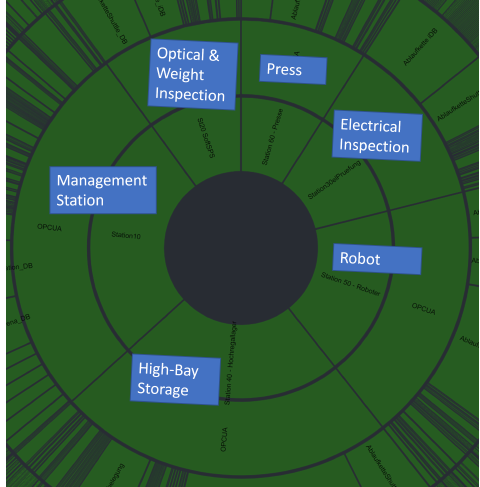
Figure 8. OPC UA Hierarchy (33,089 Variables) visualized in a sunburst chart. The more variables that exist in a subtree, the larger the